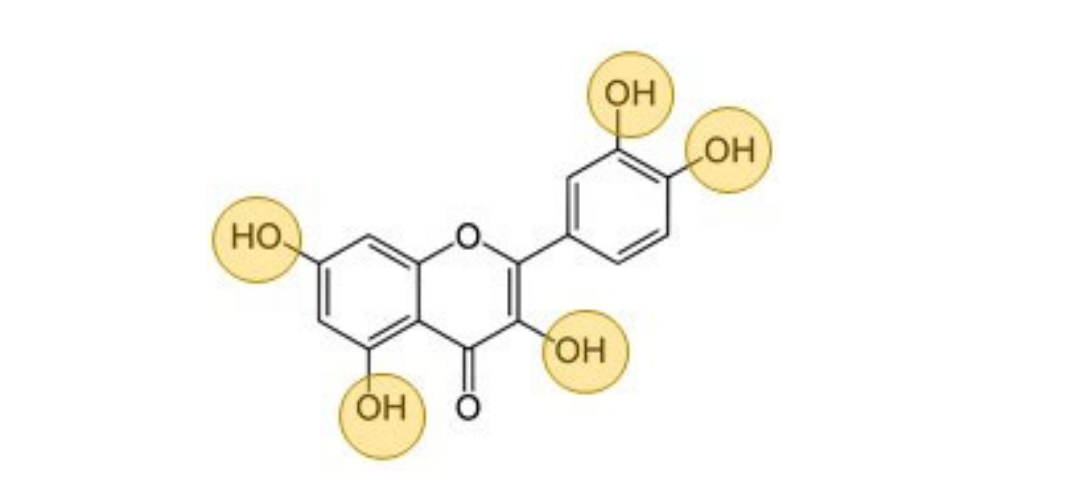
Figure 1. The structure of quercetin containing five hydroxyl groups responsible for antioxidant and crosslinking properties.